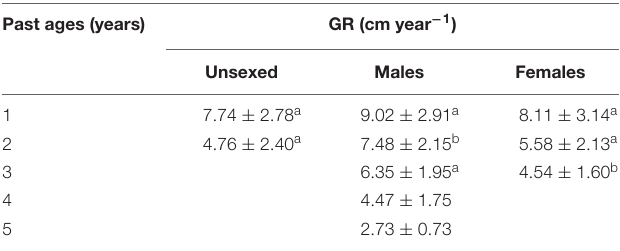
TABLE 3 | Annual growth rates ( GR , mean ± standard deviation) for past ages of C. trigloides from the southwestern Atlantic Ocean. Past ages (years)